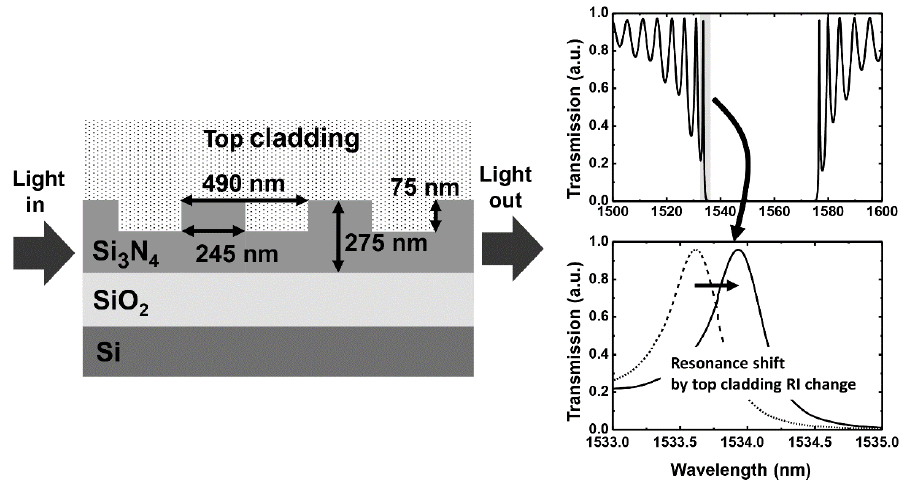
Figure 1. Schematic of a grating waveguide for a refractive index (RI) sensor and its sensing principle.